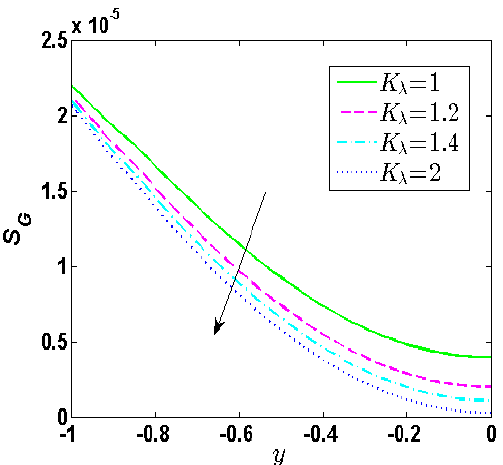
Figure 6. Distribution of entropy generation when λ = 0.25, d = 0.15, R = 1, α = 1, u r = 1, Br = 0.02, J = 5, Θ = 1000.